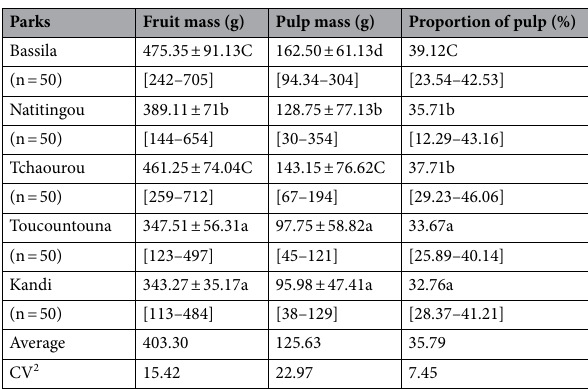
Table 2. Proportion of P. butyracea fruit pulp by park collected in June 2020 in Benin. Mean ± Standard deviation; n = number of fruits included; values with the same letter in the same column, are not significantly different at p < 0.05. CV 2 Coefficient of variation. In bracket [minimum value–maximum value] of the